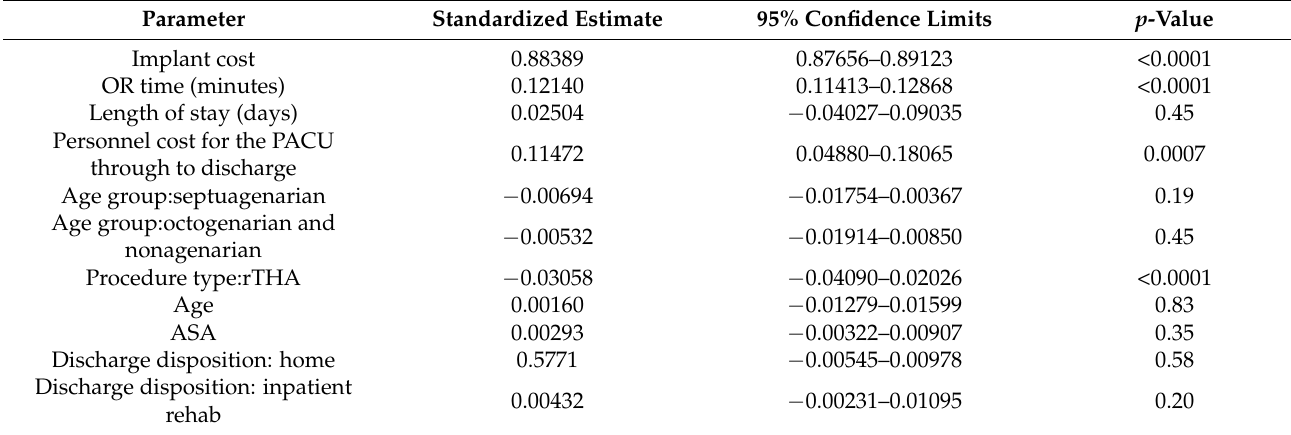
Table 5. Multivariate linear regression results for the total in-hospital cost. Adjusted R-square = 0.9945. ASA—American Society of Anesthesiologists classification, PACU—post-anesthesia care